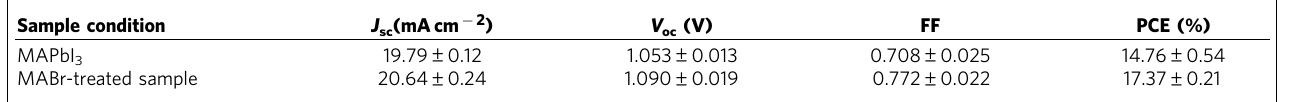
FF, fill factor; MABr, methylammonium bromide; PCE, power conversion efficiency; PSC, perovskite solar cell. S.D.’s from 8 to 12 cells for each type of devices are given. For these devices, relatively poor-quality MAPbI 3 films (Fig. 1a) were used as the initial films prior to MABr